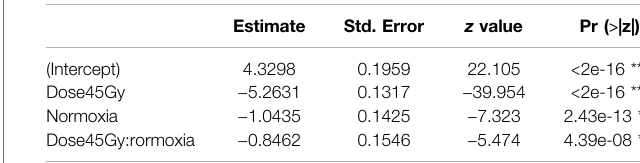
TABLE 5 | Fixed effect of anoxia on adult dose-response.